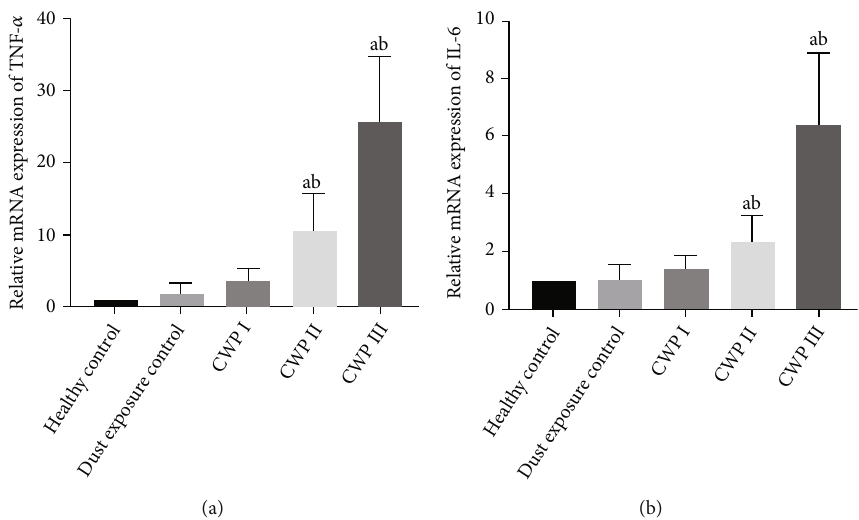
Figure 3: Relative expression of TNF- α and IL-6 mRNA. (a) The relative mRNA expression levels of TNF- α . (b) The relative mRNA expression levels of IL-6. a P < 0 : 05 , compared with the healthy control group. b P < 0 : 05 , compared with the dust exposure control